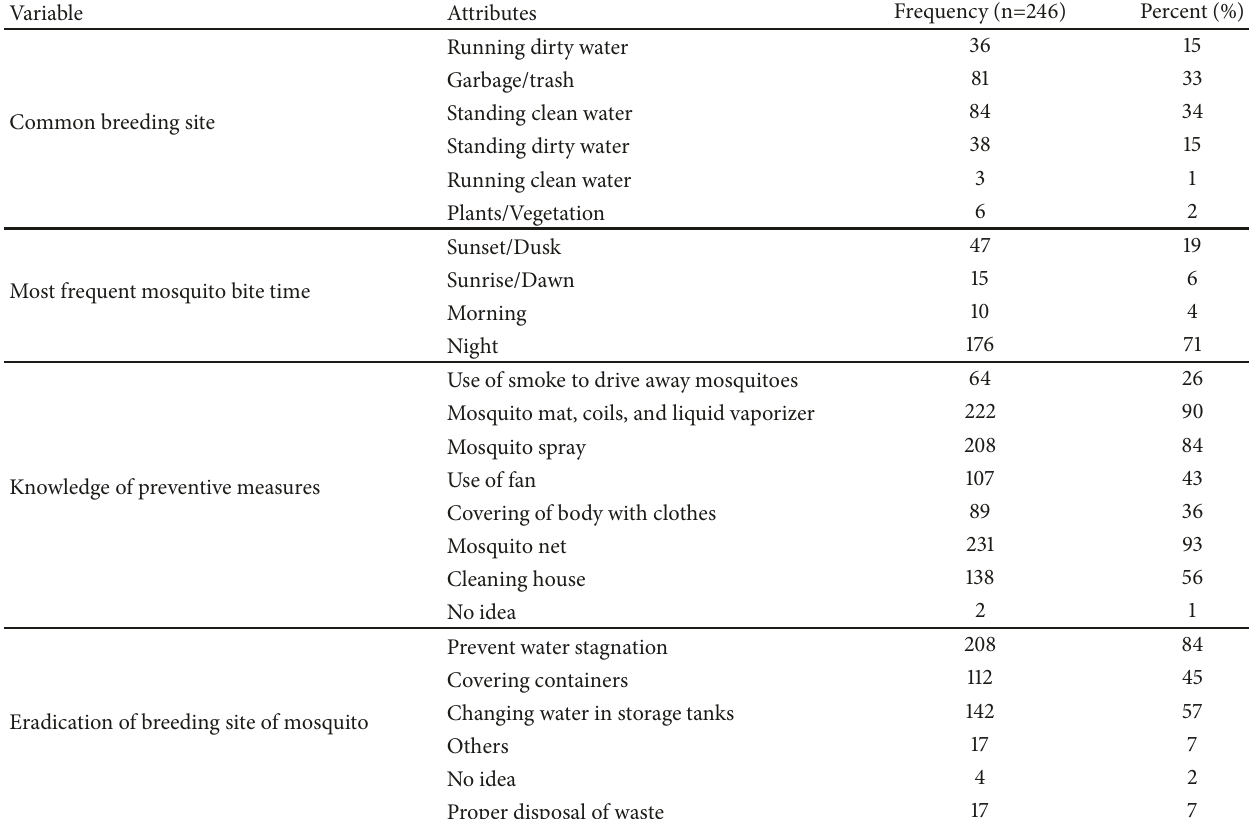
Table 3: Knowledge of vector characteristics and preventive measures.